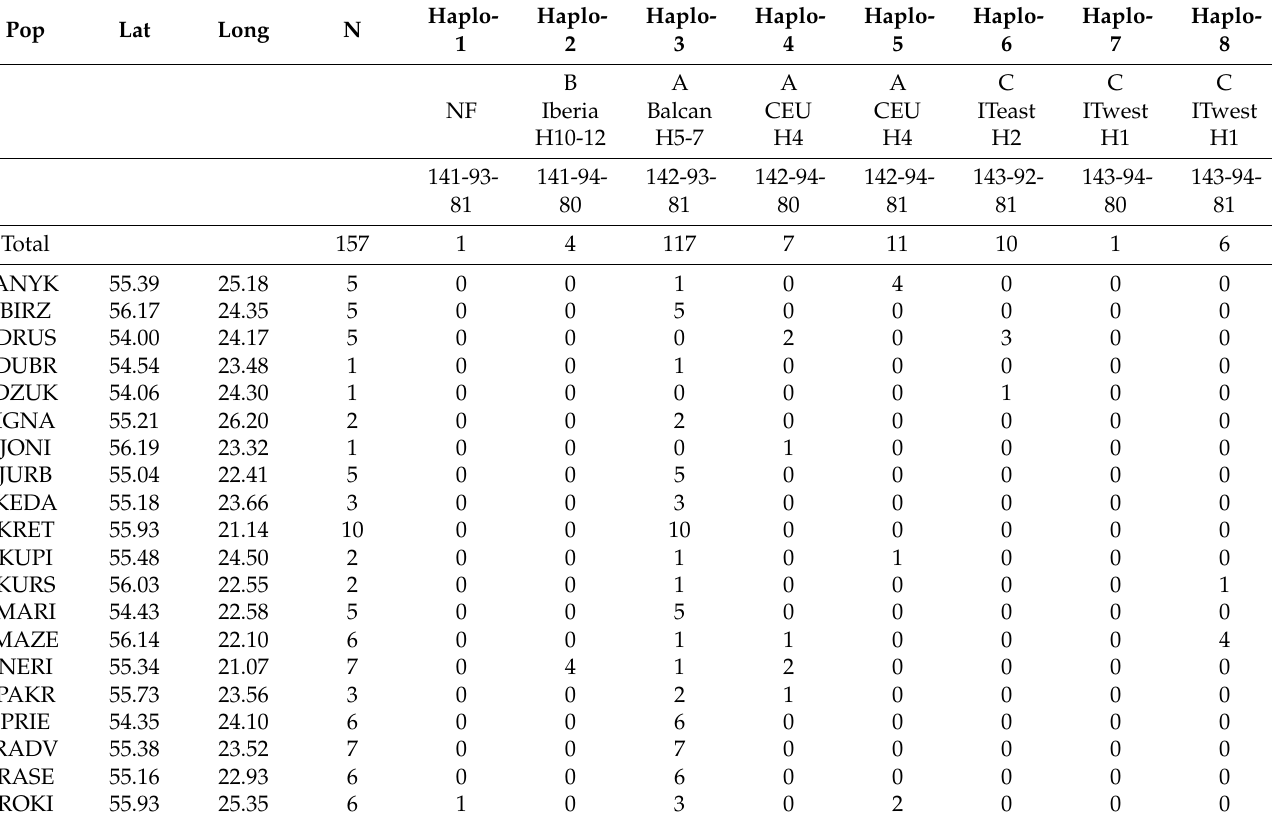
Table 1. Location of the populations and the number of the cpSSR haplotypes found in each population. N is the sample size.